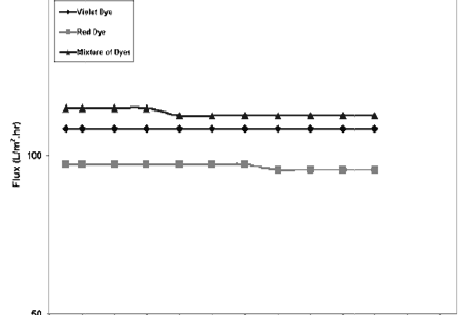
a function of concentration